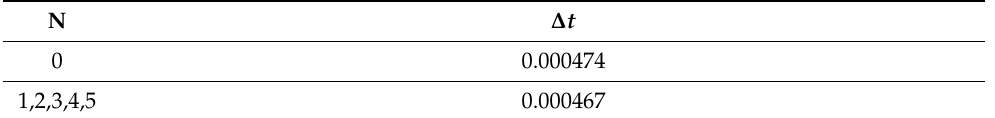
Figure 11. Standard dam break test case with standard parameters [3] for varying N at t = 0.2 shows the convergence of the HSWME model. Table 3. Maximum stable outer time step size ∆ t for varying N , constant CFL number CFL ≈ 0.7 and ∆ x = 0.001 for dam break test case.